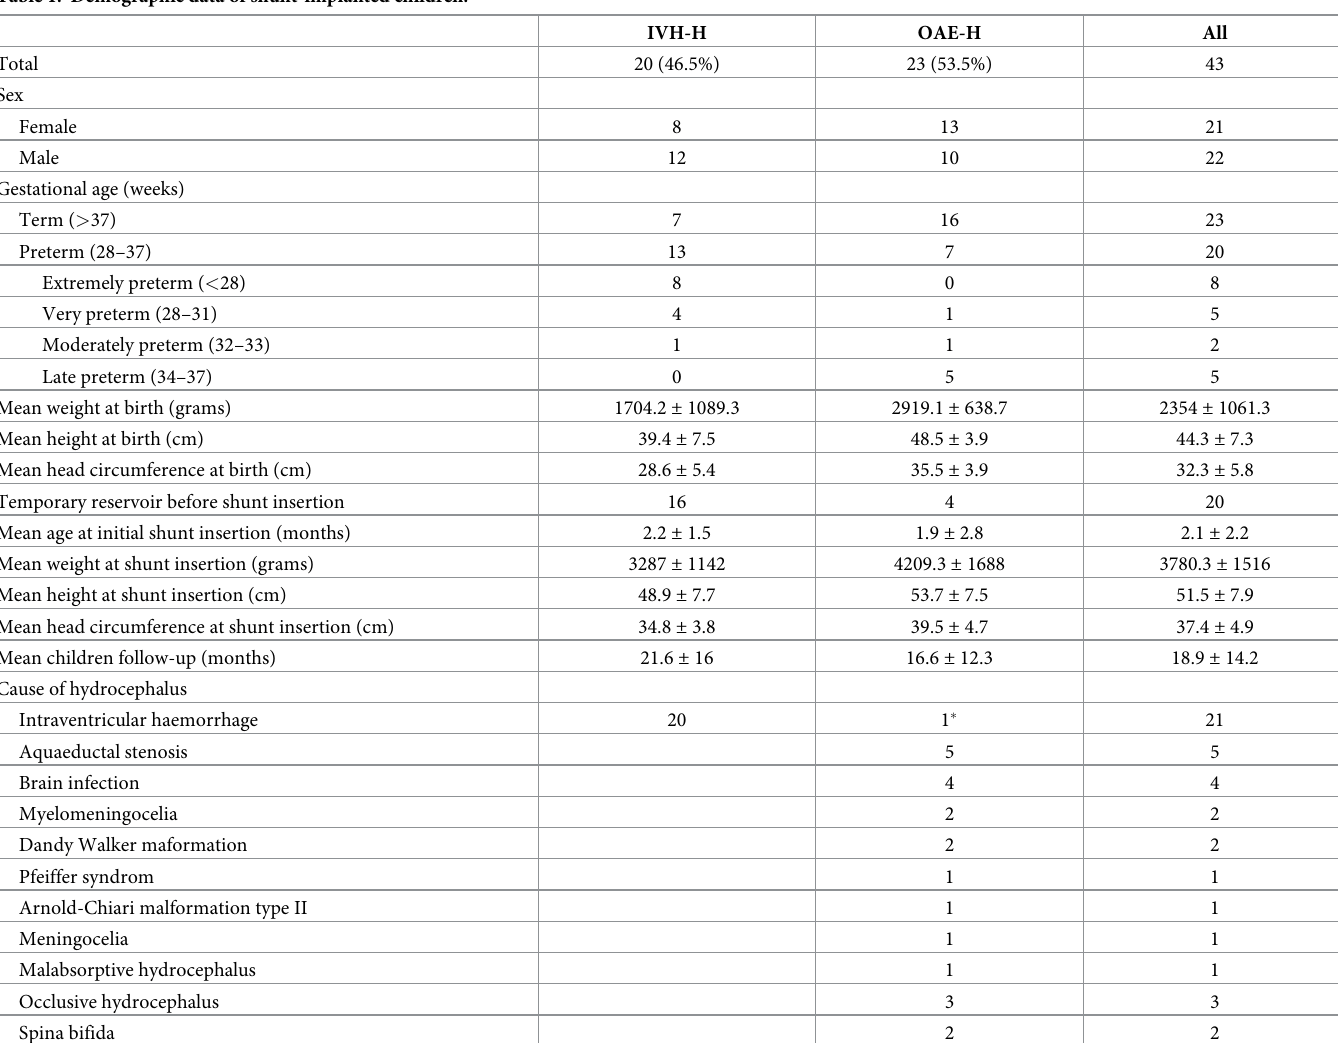
Table 1. Demographic data of shunt-implanted children.